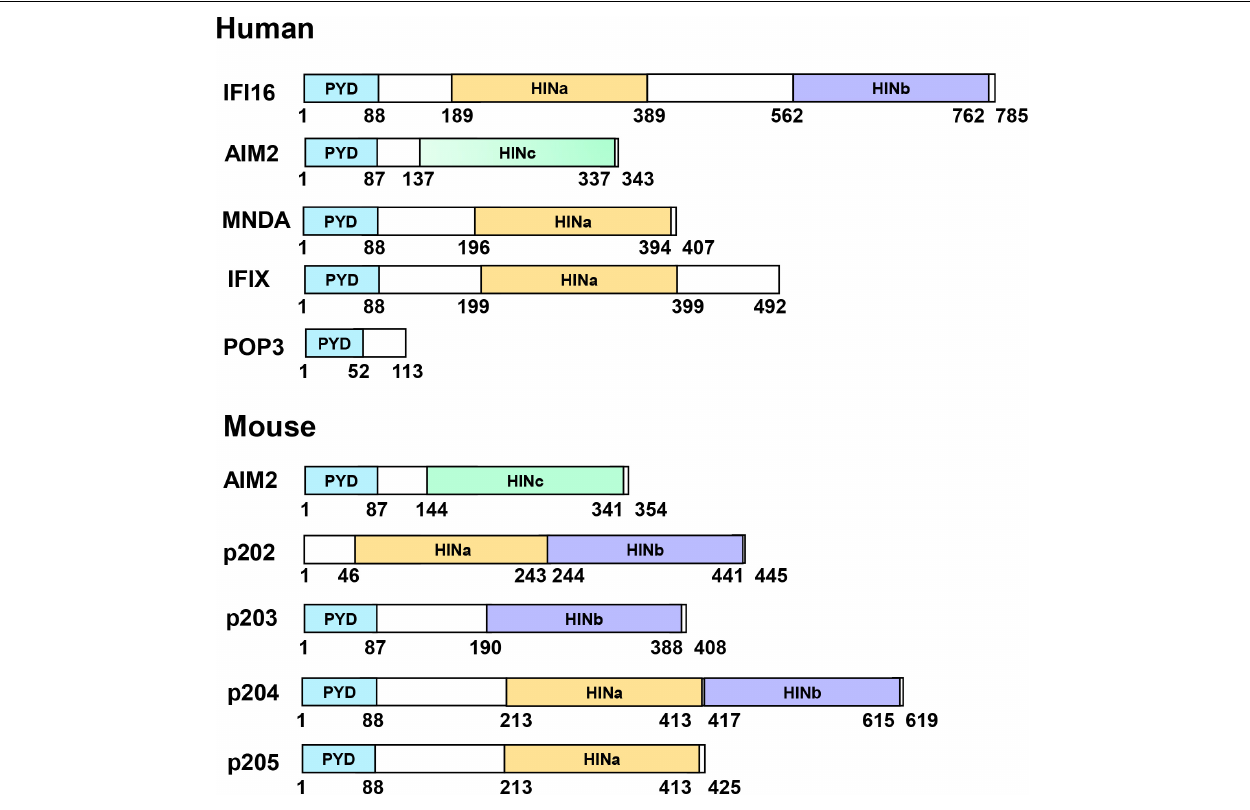
FIGURE 1 | Domain organization of PYHIN family proteins. PYHIN family members possess an N-terminal pyrin domain (PYD) and one or two C-terminal HIN domains, classified as three subtypes; HIN A, HIN B, or HIN C. p202 from mouse lacks PYD and POP3 from human lacks of HIN